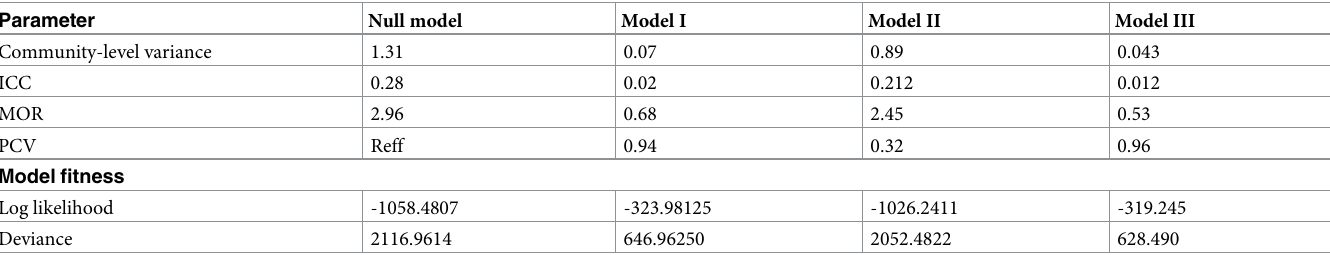
Table 3. Random effect model and model fitness for the assessment of adolescent fatherhood in